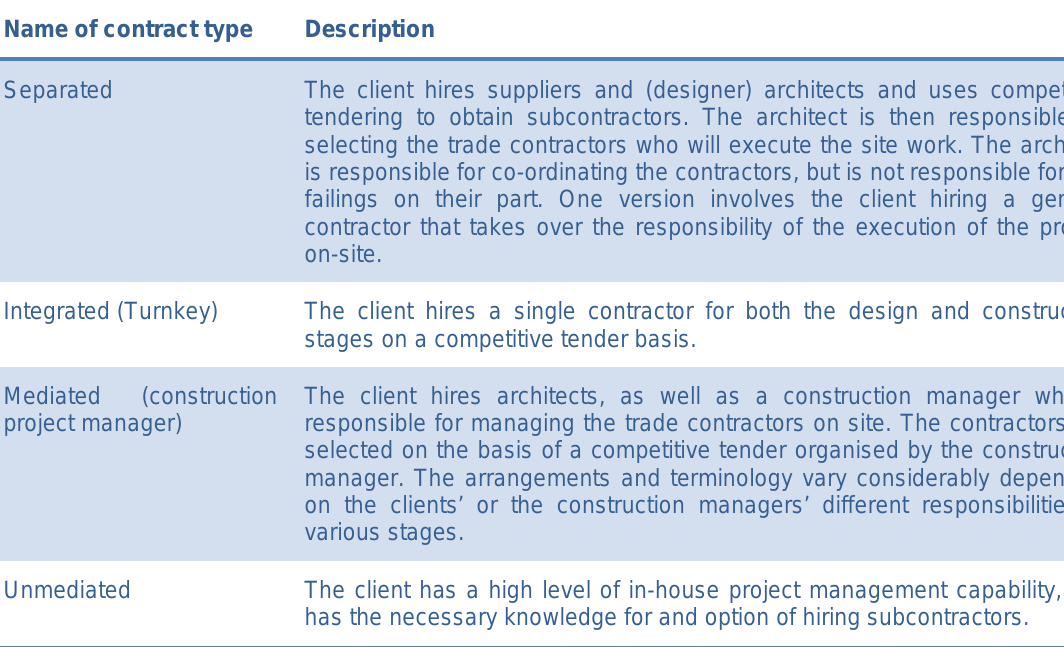
Table 2: Contract structure in Winch (2010, Ch.